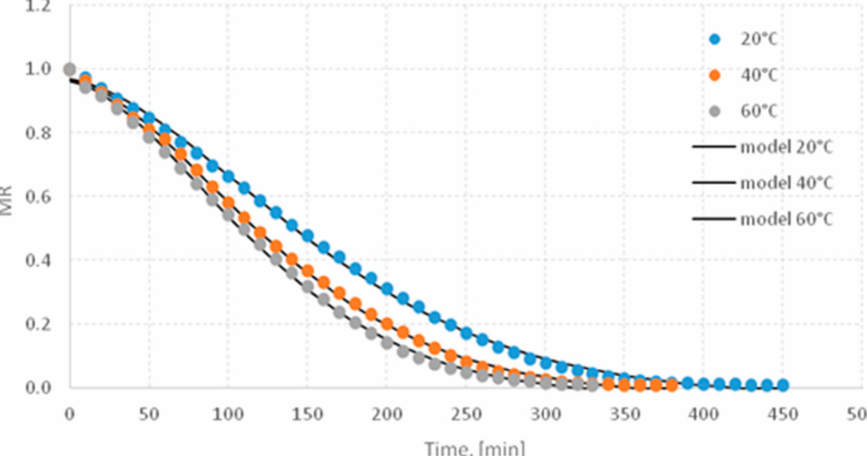
Figure 2. Drying curves of freeze-drying of strawberry pulp, MR —moisture